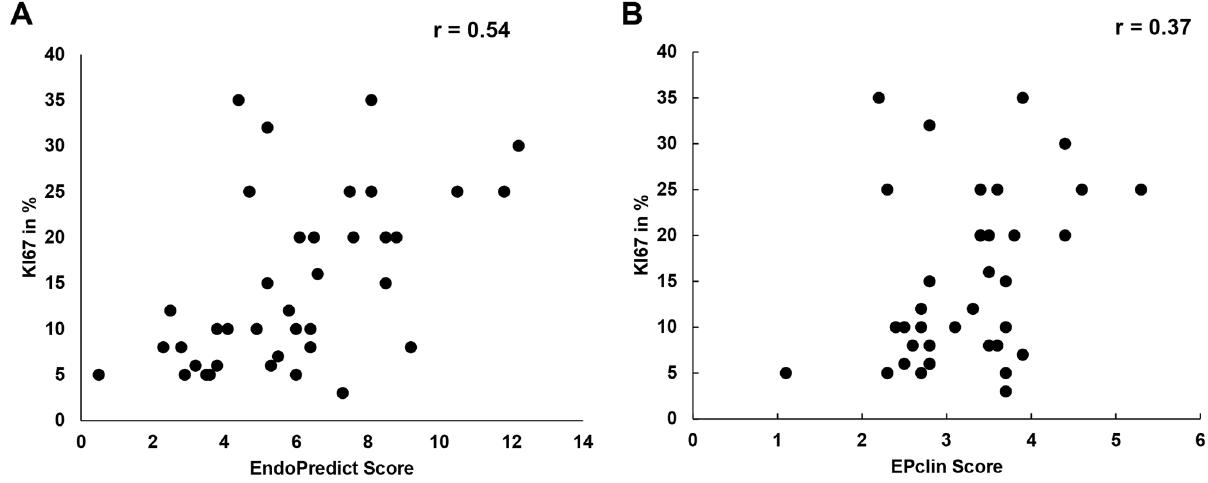
Fig 1. Comparison of proliferative index (Ki67) with EP score (A) and EPclin score (B). r = Pearson coefficient.